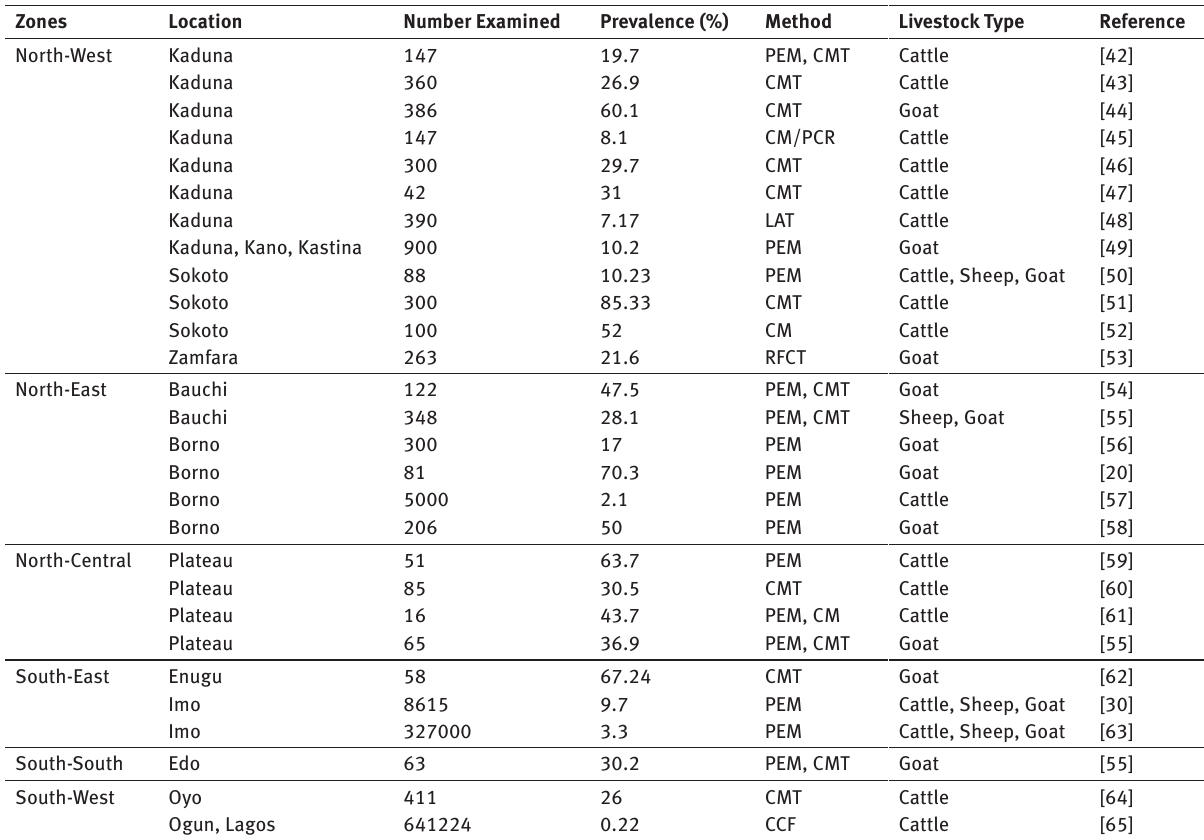
Table 2 Prevalence of Mastitis in livestock across the states and zones in Nigeria Zones